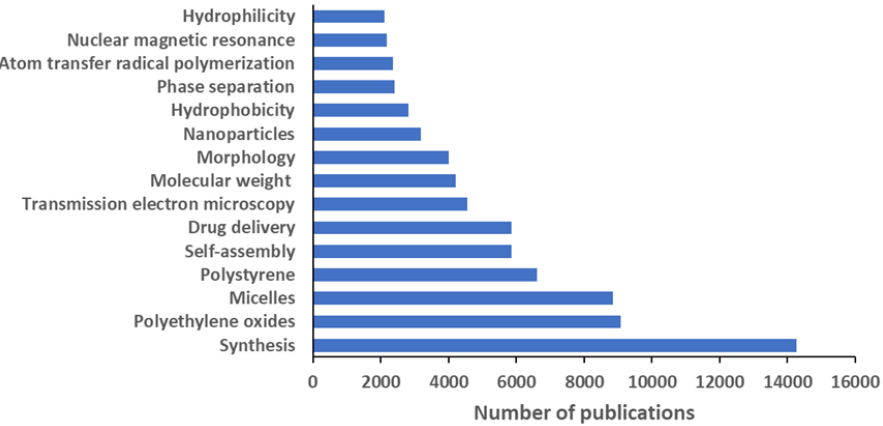
Figure 9. Top 15 keywords in scientific research on block copolymers. ‘ Synthesis ’ refers to the sum of the keywords ‘ copolymerization ’ , ‘ polymerization ’ , ‘ synthesis ’ , and ‘ synthesis (chemical) ’ ; ‘ polyethylene oxides ’ also refers to the sister keyword ‘ polyethylene glycols ’ ; ‘ micelles ’ also refers to the keyword ‘ micelle ’ ; ‘ polystyrene ’ also refers to ‘ polystyrenes ’ ; ‘ self-assembly ’ also refers to ‘ self assembly ’ ; ‘ drug delivery ’ includes the keywords ‘ drug delivery system ’ , ‘ drug delivery systems ’ , ‘ controlled drug delivery ’ , ‘ drug carrier ’ , and ‘ drug carriers ’ ; ‘ transmission electron microscopy ’ also refers to ‘ high-resolution transmission electron microscopy ’ .